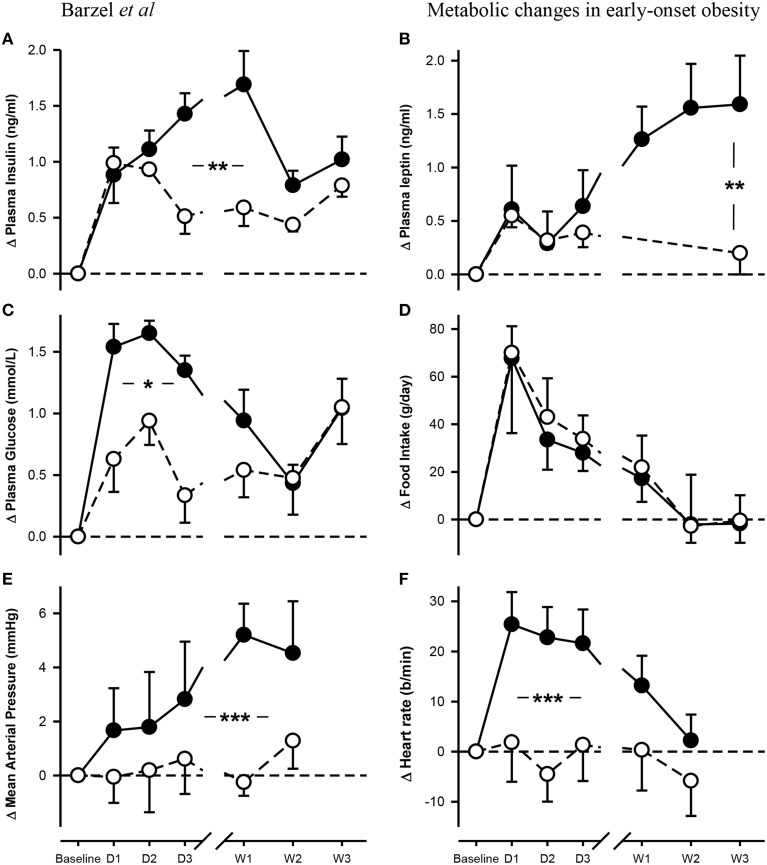
Changes from baseline in levels of plasma insulin (A), leptin (B) and glucose (C) concentrations, food intake (D), mean arterial pressure (E) and heart rate (F) in rabbits fed either a normal fat diet (open circles) or a high-fat diet (closed circles) for 3 weeks. Data are mean difference ± SED, *P < 0.05, **P < 0.01, ***P < 0.001 for differences between dietary groups. Day, D; Week, W.